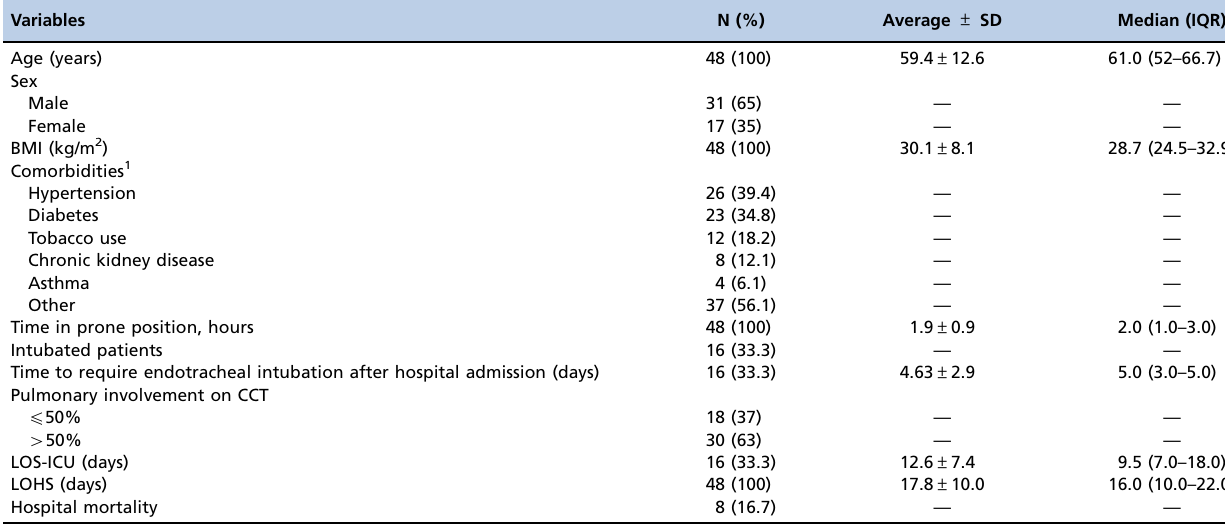
Figure 1 - Study flow diagram. Table 1 - Clinical and demographic data of the